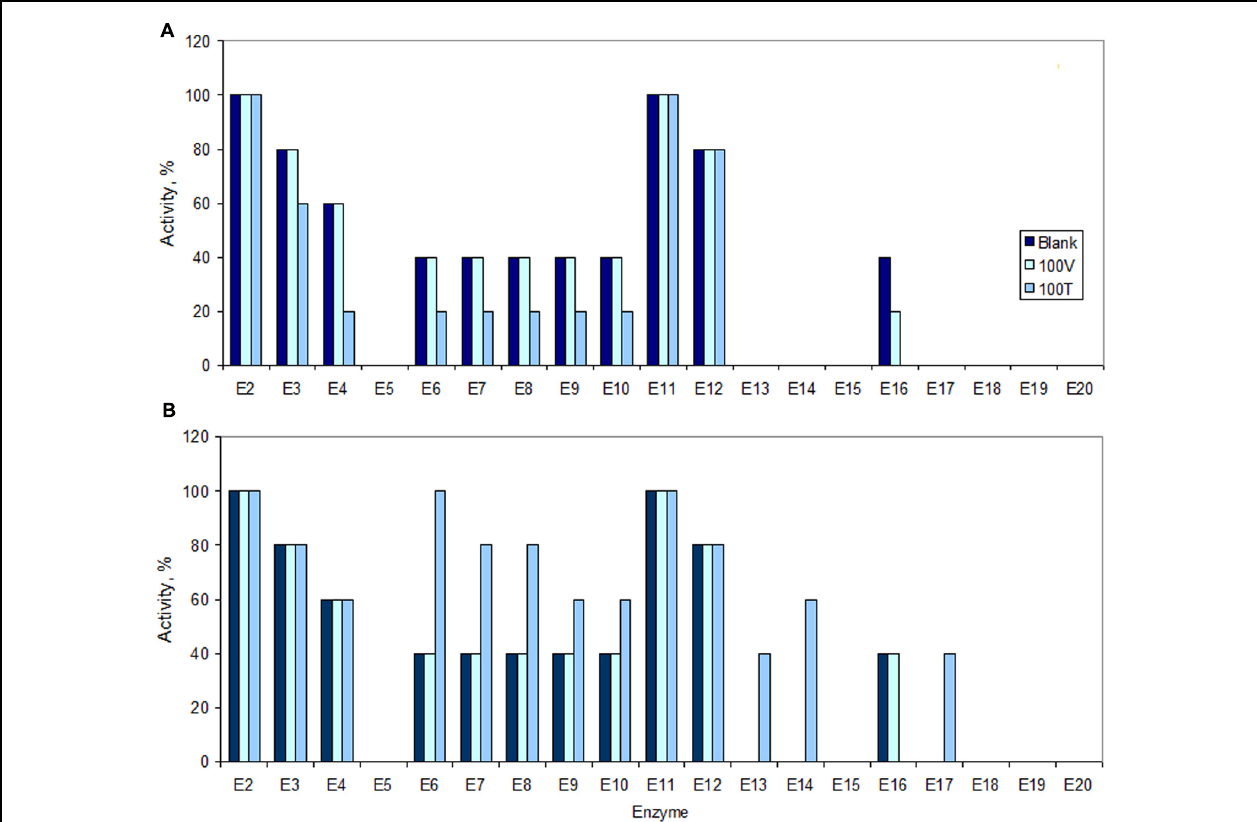
FIGURE 8 | Activity of enzymes in S. aureus cells under no-stress conditions (Blank), following 8 h of exposure (A) to 100 mg/L of vancomycin (100 V) and teicoplanin (100 T), and following 5 h of post-antibiotic growth in fresh, drug-free MHB (B). The maximum activity (100%) is referred to the maximum color intensity (5) suggested by the kit. The horizontal axis corresponds to the following enzymes: E2, alkaline phosphatase; E3, esterase (C4); E4, esterase lipase (C8); E5, lipase (C14); E6, leucine arylamidase; E7, valine arylamidase; E8, cystine arylamidase; E9, trypsin; E10, α -chymotrypsin; E11, acid phosphatase; E12, Naphtol-AS-BI-phosphohydrolase; E13, α -galactosidase; E14, β -galactosidase: E15, β -glucuronidase; E16, α -glucosidase; E17, β -glucosidase; E18, N -acetyl- β -glucosaminidase; E19, α -mannosidase; E20, α